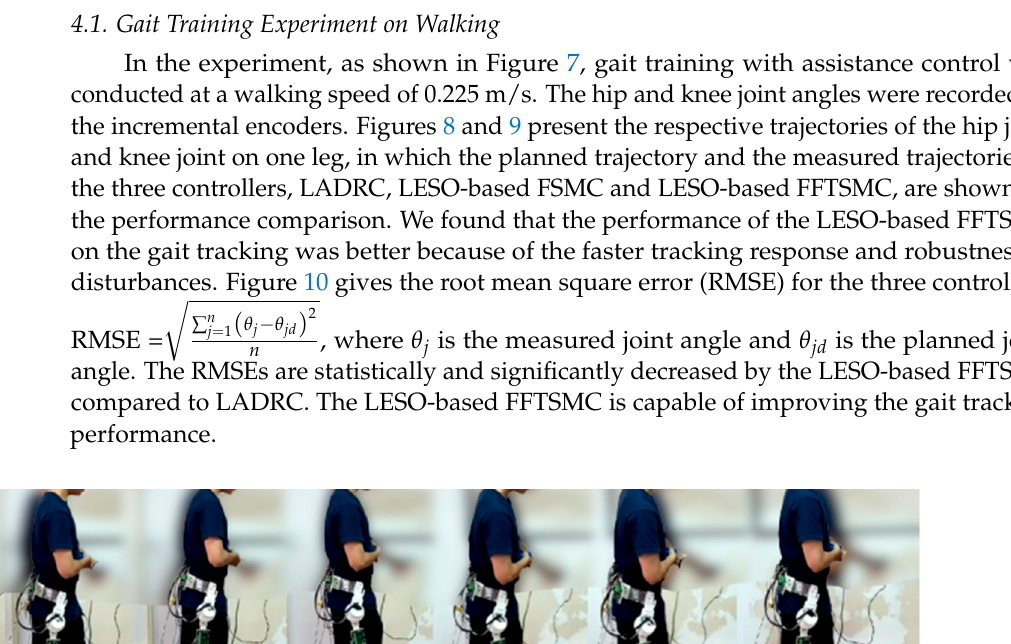
Figure 8. Trajectories of hip joint for proposed LESO-based controllers.